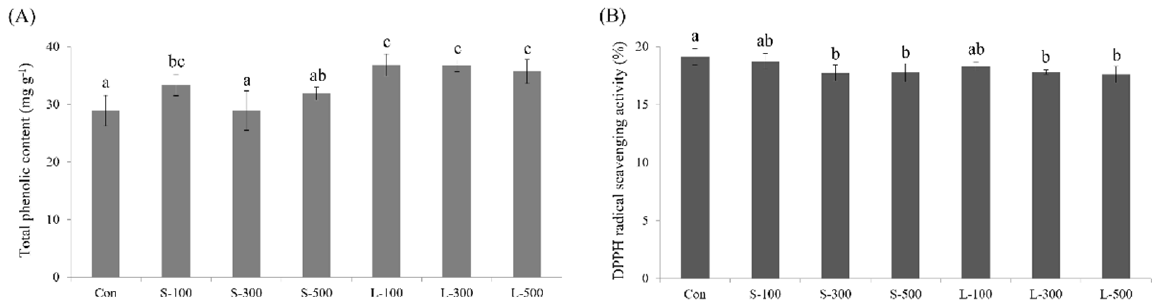
Figure 8. Different gamma radiation dose and exposure time effects on the ( A ) total phenolic content and ( B ) DPPH free radical scavenging activity. Each bar represents the mean ± SD ( n = 3). Values with different letters are significantly different using Duncan’s multiple range test ( p < 0.05).